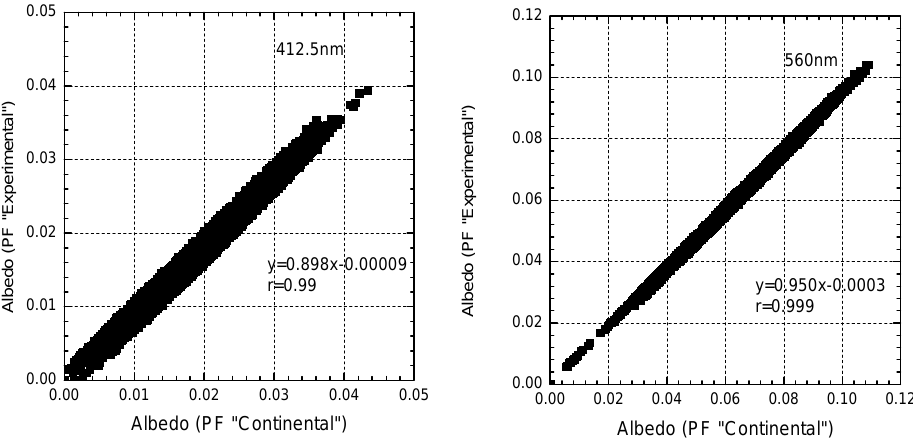
Fig. 23. Surface albedo retrieved with the experimental phase function versus the same value retrieved with the Continental phase function at wavelengths of 412.5nm (left) and 560nm (right). r is the correlation coefficient.